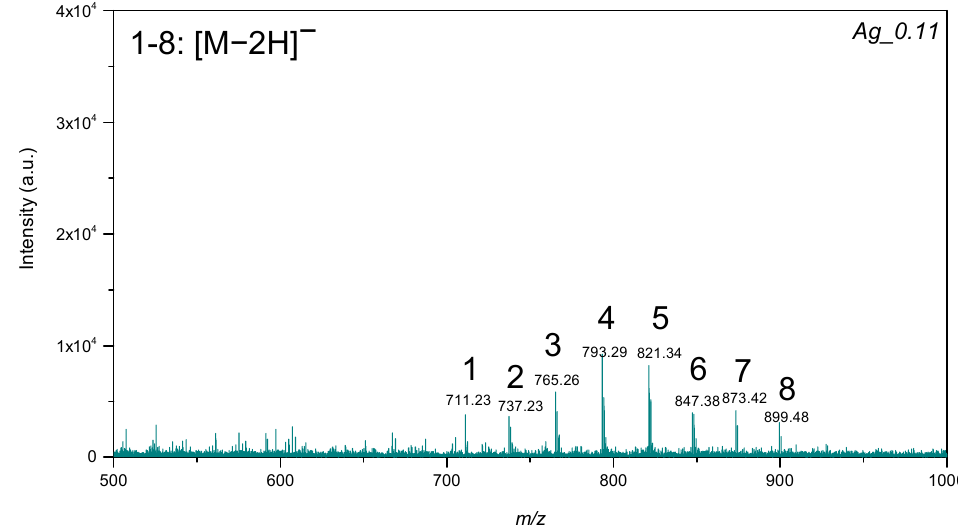
Figure 5. LDI-MS spectra of the standard mixture of triacylglycerols, where 1—14:0-13:0-14:0 TG (25 µg/mL); 2—14:0-15:1-14:0 TG (50 µg/mL); 3—14:0-17:1-14:0 TG (75 µg/mL); 4—16:0-15:1-16:0 TG (100 µg/mL); 5—16:0-17:1-16:0 TG (125 µg/mL); 6—16:0-19:2-16:0 (100 µg/mL); 7—18:1-17:1-18:1 TG (75 µg/mL); 8—18:1-19:2-18:1 TG (50 µg/mL). Triacylglycerols were also detected for all plates in ion-positive mode (Figure 6). The heatmap (Figure 6) presents intensities for molecular ions assigned as an adduct such as